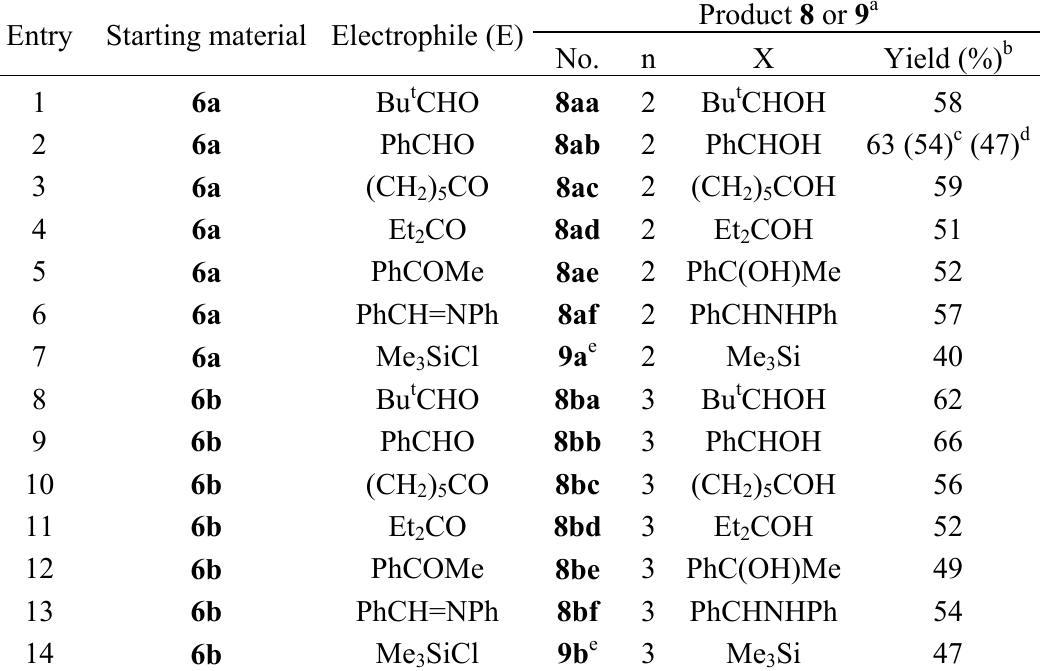
Product 8 or 9 a